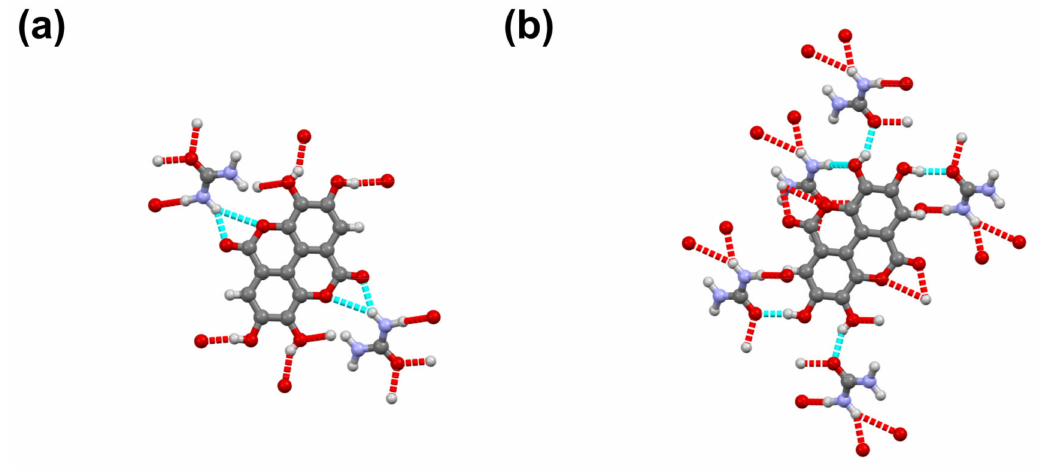
Figure 9. ( a ) Hydrogen bonds in UE between urea amide group and ellagic acid carbonyl group. ( b ) Hydrogen bonds formed by the phenol group in